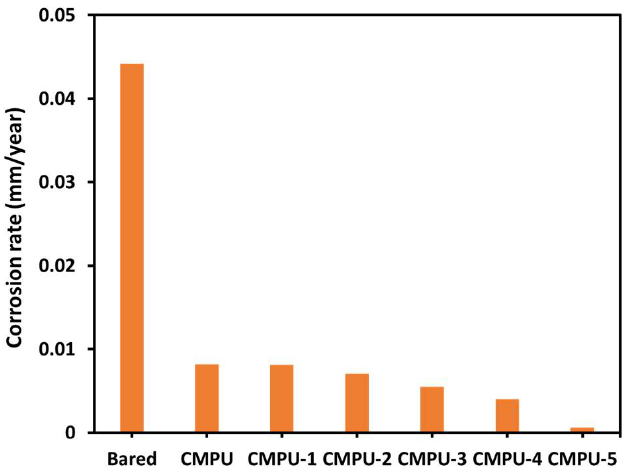
Figure 10. Corrosion rate of bare, CMPU, CMPU-1, CMPU-2, CMPU-3, CMPU-4, and CMPU-5 coated samples tested against aq. 3.5% NaCl medium.